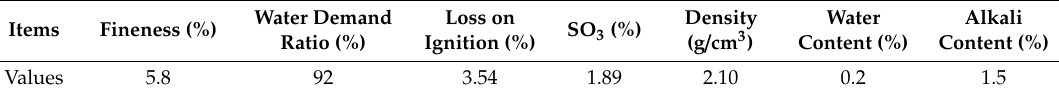
Table 1. Properties of the fly ashes used in this study.